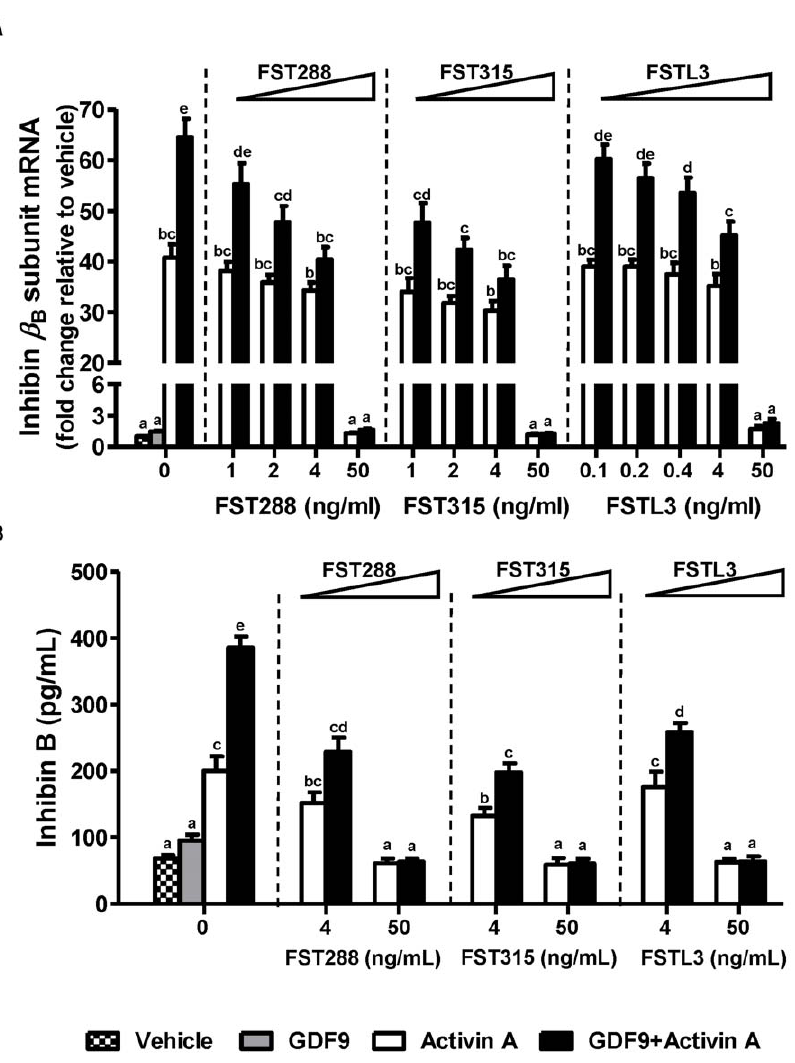
Figure 5. GDF9 pretreatment enhanced activin A-induced inhibin b B -subunit and inhibin B expression, effects attenuated by FST/ FSTL3. After 48 h preculture, the culture media were replaced by low-serum media (0.5% FBS), and hGL cells were cultured with and without 100 ng/ml GDF9 for another 24 h in low-serum media. Different dose of FST288, FST315 or FSTL3 were preincubated with 25 ng activin A at 37 C for 1 h in 50 m l PBS containing 0.1% BSA before adding to the cells and cultured for another 24 h. Inhibin b B -subunit mRNA levels in hGL cells (A) and inhibin B protein levels in culture media (B) were measured by real-time PCR and ELISA respectively. Results were the means 6 SEM from at least four sets of experiments (each from a separate patient), and in each set, measurements were made in triplicate for real-time PCR and duplicate for ELISA. Means without a common letter are significantly different ( P , 0.05).